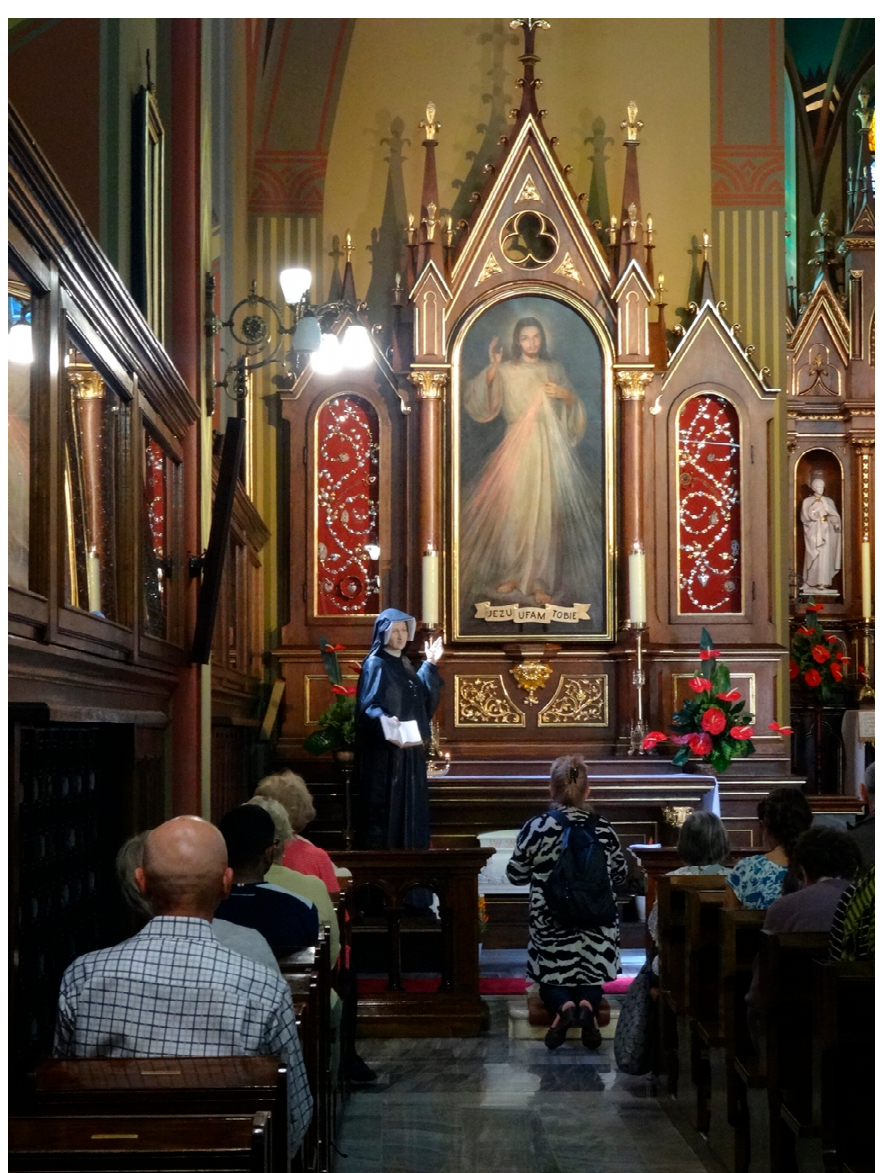
Figure 1. The Divine Mercy image (Adolf Hyła) located in the convent chapel of the Sisters of Our Lady of Mercy, Łagiewniki, Poland. Photograph by Robert E. Alvis. Note: This article has obtained the right to use this